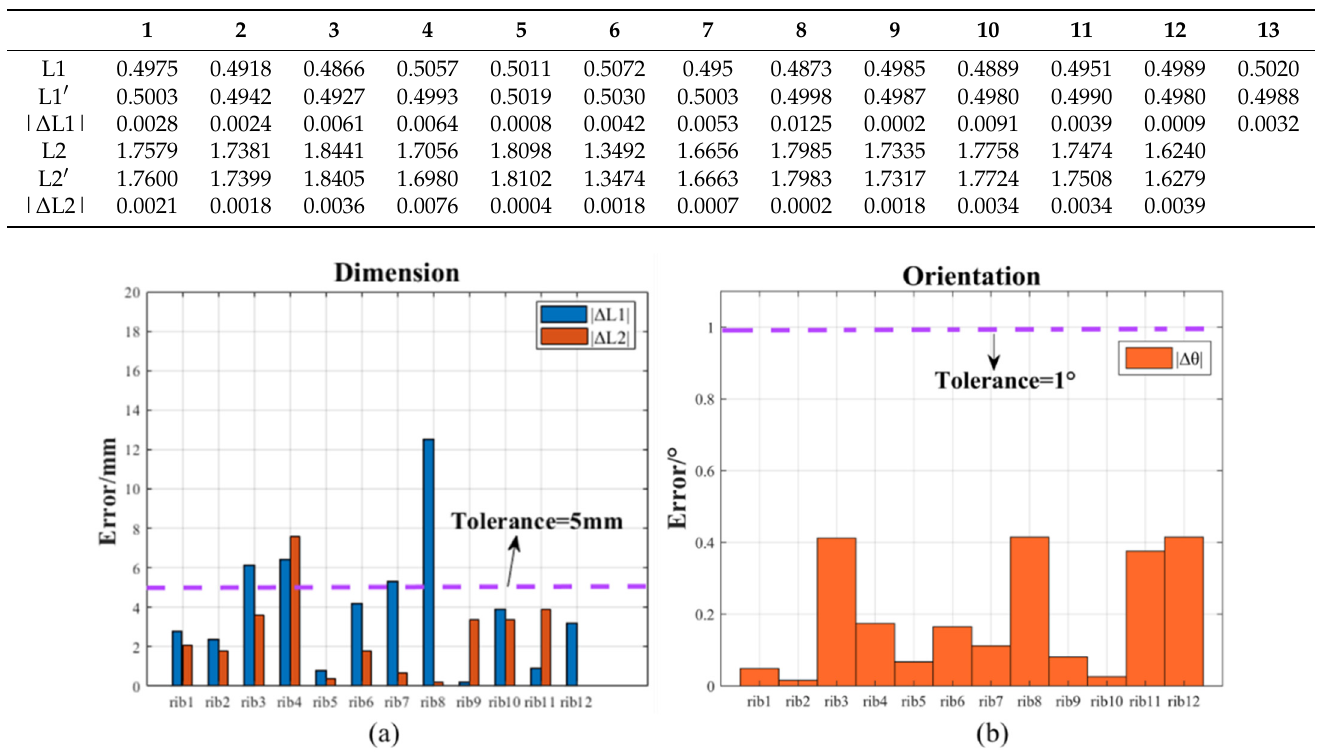
Figure 14. Geometric quality assessment results of prefabricated T ribs compared with manual measurement results: ( a ) T-rib dimensions and positions and ( b ) T-rib orientations.